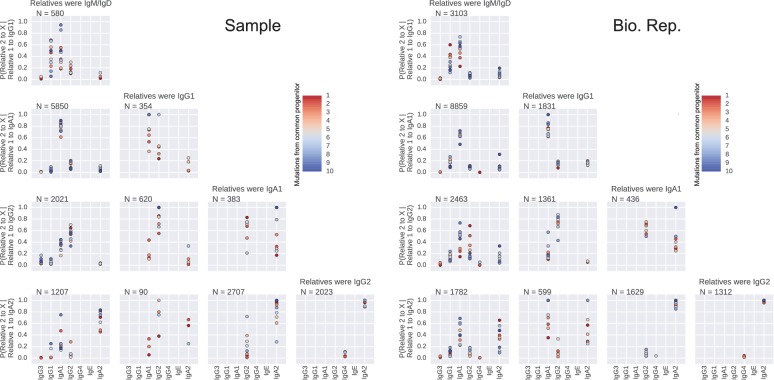
Closely related B cells often switch to the same class.Probability distributions of class switch fate conditioned upon the fate of closely related cell. These plots represent the probability distribution of class switch fate of 'Related cell 2', given the fate of 'Related cell 1'. Column header indicates class of the related sequences. X-axis label of each row indicates the class switch fate of 'Related cell 1'. Color indicates the relatedness of the cells, measured by the number of mutations from common progenitor. Number of sequence pairs contributing to each panel N is shown. Right panel shows original samples and left panel shows biological replicates.